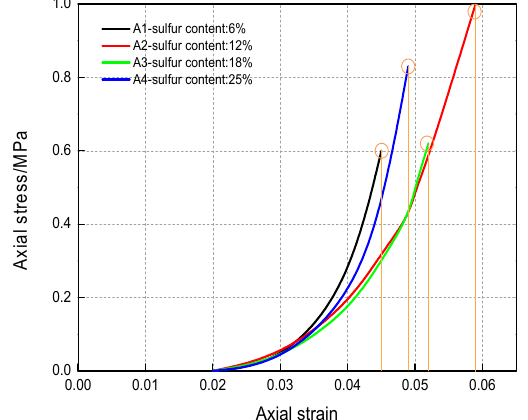
Figure 5. Damage Value and Axial Strain Curve of CSTB [32].